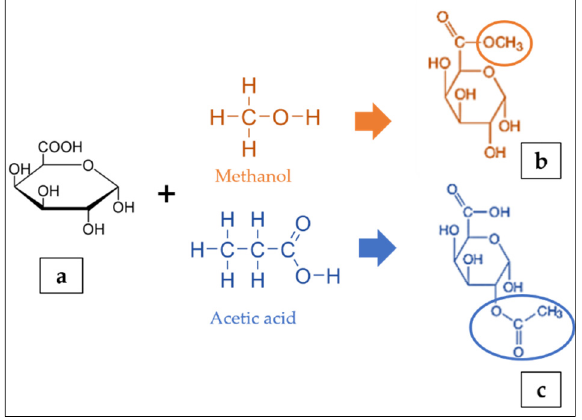
Figure 2. Structure of galacturonic acid ( a ) presenting methyl esterified ( b ) and acetylated ( c ) forms adapted from [122] .